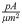
Dynamics of the Ca2+ concentration in the intracellular compartment under synaptic stimulation for a blocked glutamate transporter (GluT) in comparison to the control condition.a The astrocytic compartment was stimulated for 10 seconds with a Poisson spike train of 10 Hz. The corresponding glutamate concentration in the extracellular compartment as a function of time was calculated using the Tsodyks and Markram model. b Reduction of the Ca2+ response under block of the GluT as a function of the maximal pump current of the Na+/Ca2+ exchanger (INCXmax) and the volume ratio (ratioER) between the internal Ca2+ store and the intracellular compartment. The reduction was quantified by the difference of the average Ca2+ concentration under control condition and block normalized by the difference between the Ca2+ concentration in the control condition and the Ca2+ concentration without stimulation. Solid lines separate the parameter space concerning the reduction: larger than 80%, between 40% and 80% and under 40%. c-e Ca2+ response as a function of time for different values of INCXmax and ratioER correspond to a reduction of the Ca2+ signal of 29%, 67% and 97%. Solid and dashed lines correspond to control condition and block. The block was simulated by setting IGluTmax equal to 0 pAμm2.